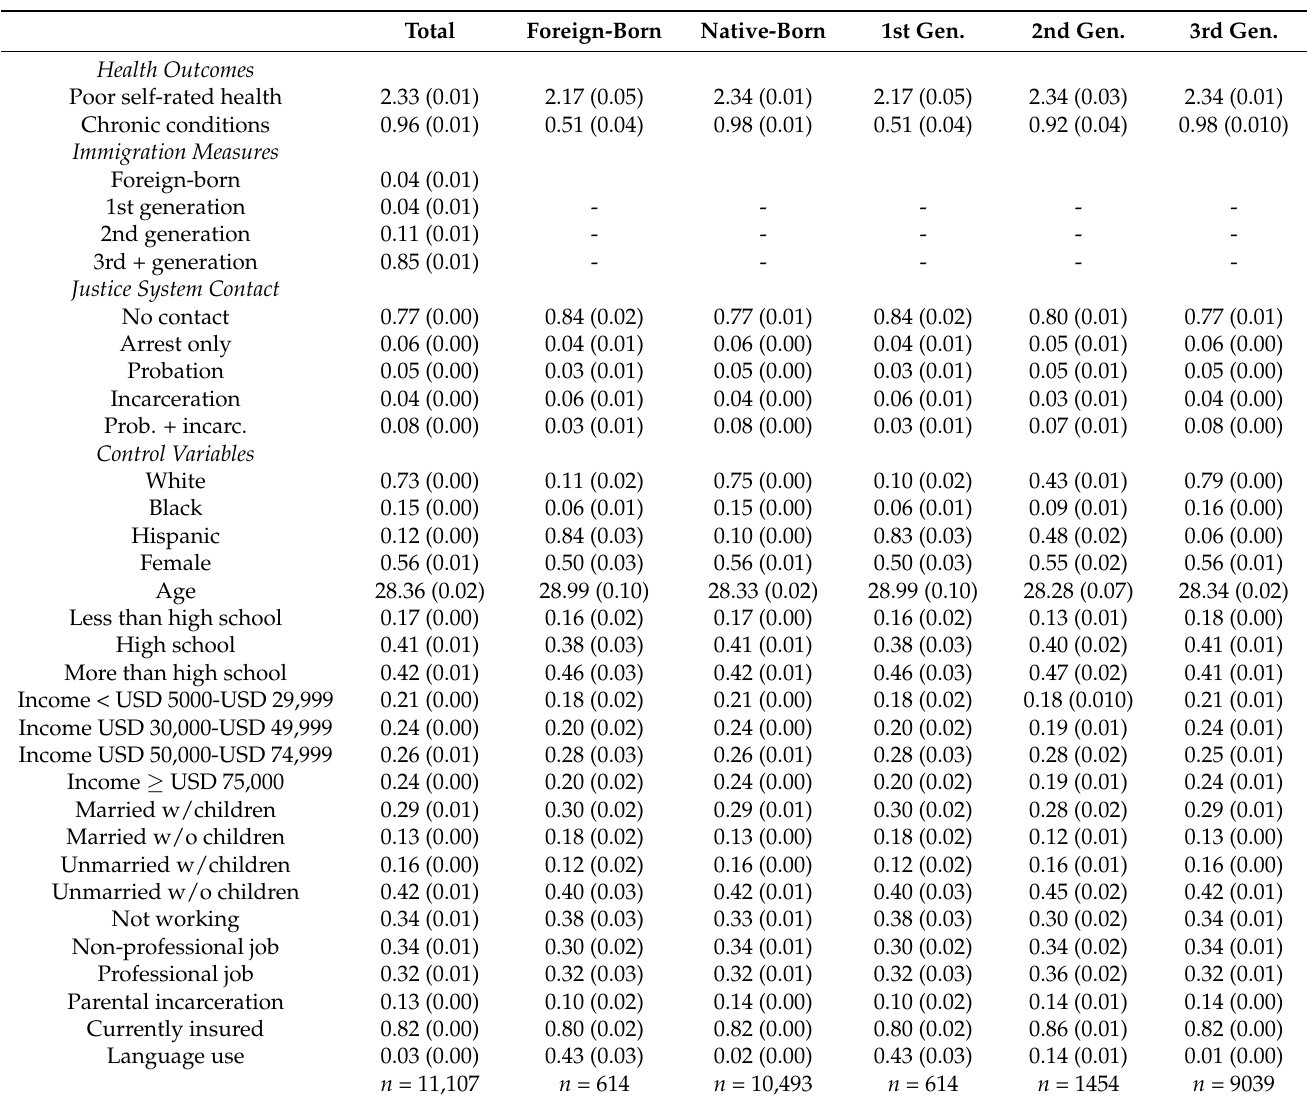
Table 1. Descriptive statistics for the total sample and by nativity and immigrant generation in Wave IV of the National Longitudinal Study of Adolescent Health. Total Foreign-Born Native-Born 1st Gen. 2nd Gen. 3rd